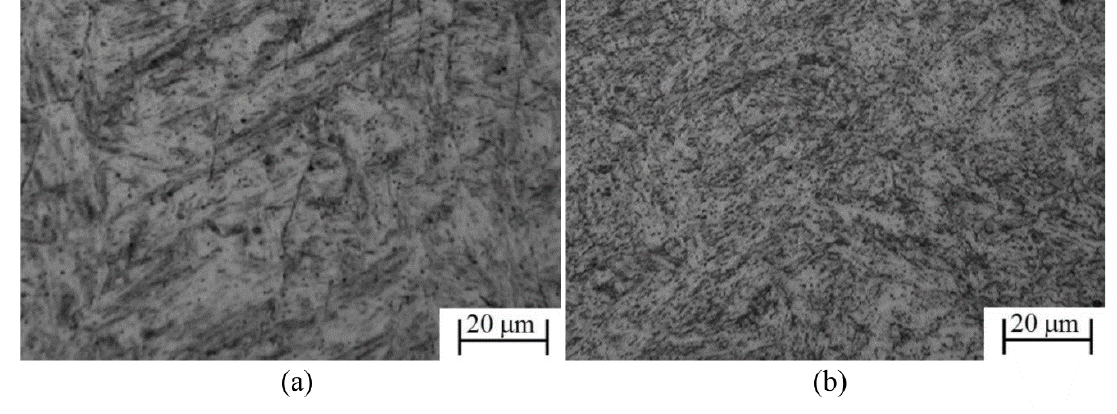
Figure 8. Weld metal microstructure (a) as welded; (b) after PWHT.